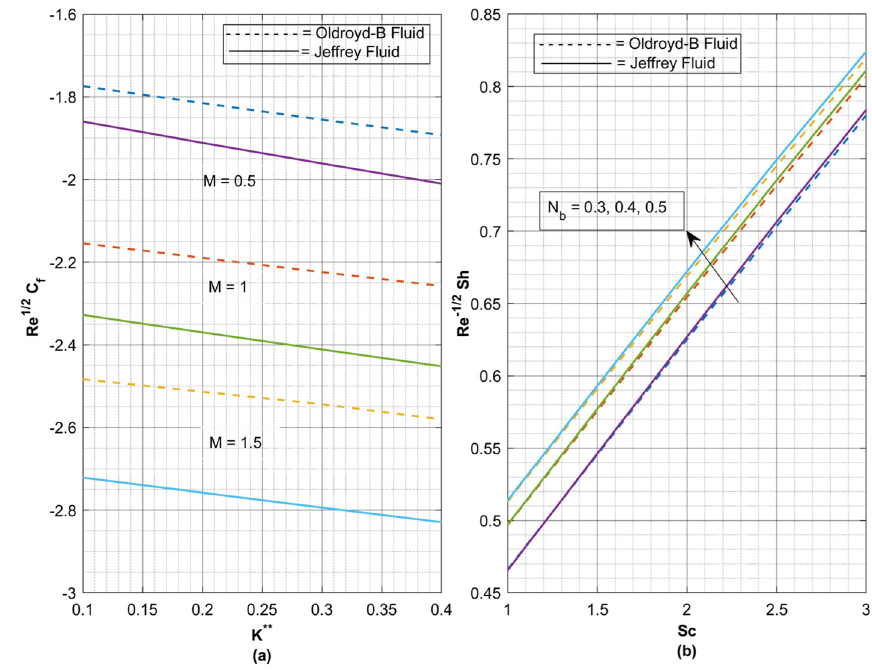
Figure 8. ( a ) Impact of N t and γ on fluid phase Nusselt number and ( b ) Impact of N t and γ on solid phase Nusselt number.